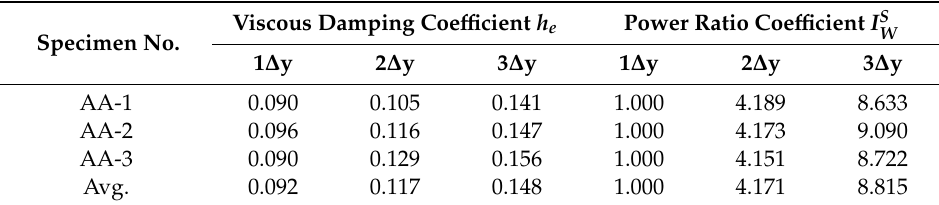
Table 2. Viscous damping coe ffi cient and power ratio coe ffi cient. Specimen